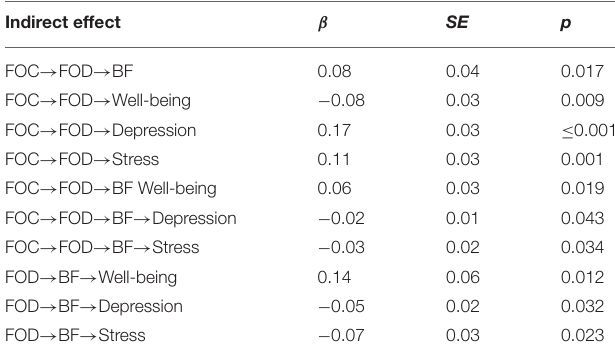
TABLE 4 | Standardized regression coefficients ( β ) and standard errors ( SE ) for indirect